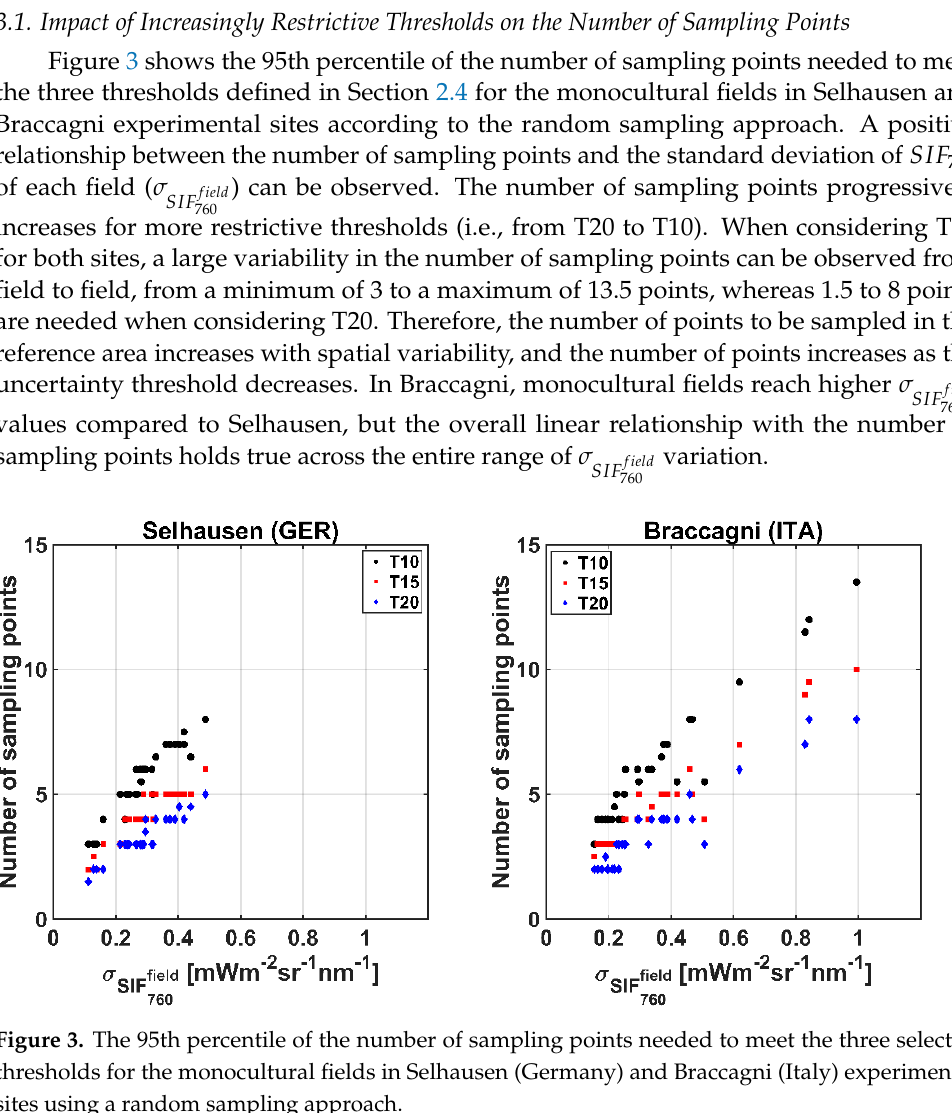
Figure 4. The 95th percentile of the number of sampling points needed to meet the thresholds for the FLEX pixels in Selhausen (Germany) and Braccagni (Italy) experimental sites using a random sampling approach.